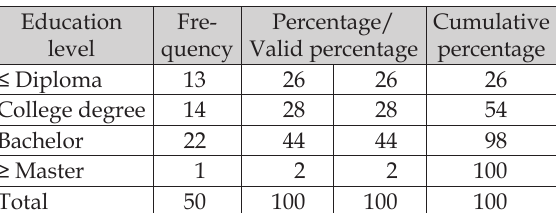
Table 4. Participants’ education status.